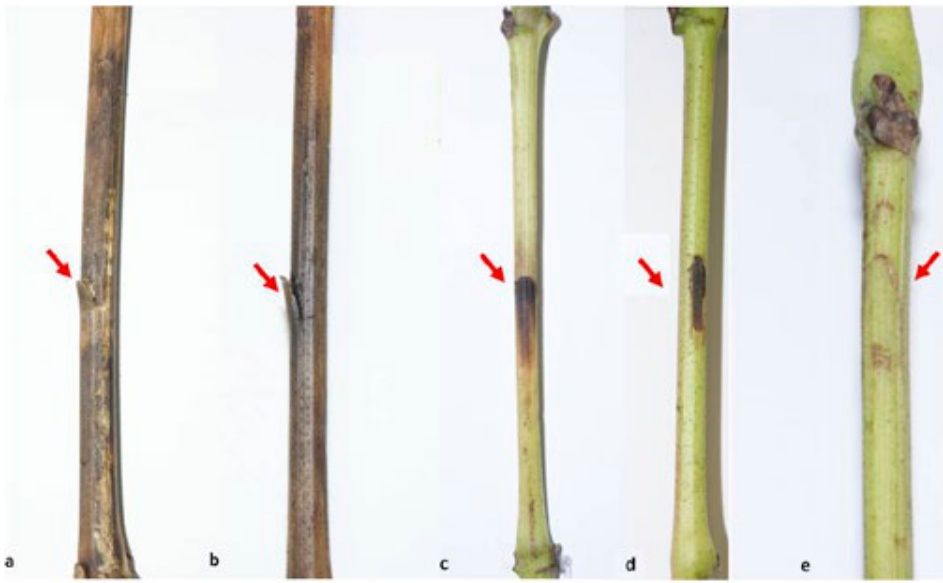
Figure 3. Discolouration on excised shoots of V. vinifera cv. Insolia 21 days after artificial inoculation with a) D. seriata, b) La- siodiplodia sp . , c) N. parvum and d) N. vitifusiforme . Arrows indicate the point of inoculation. The shoot in e) was wounded but was not inoculated with a